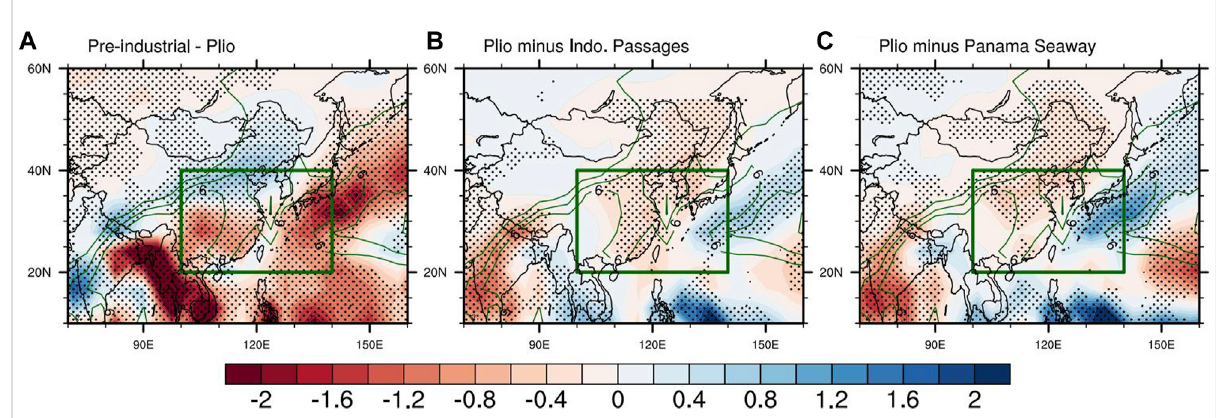
FIGURE 7 Responses (shading) ofJJA meanprecipitationto (A) decreasing CO 2 , (B) theconstriction oftheIndonesianPassagesand (C) theclosure ofthe Panama Seaway. Contours depict the JJA mean precipitation for Plio. Green box indicates the range of EASM (20 ° N – 40 ° N, 100 ° E – 140 ° E). Stippling indicates the differences for precipitation are signi fi cant at the 95% con fi dence level using Student ’ s